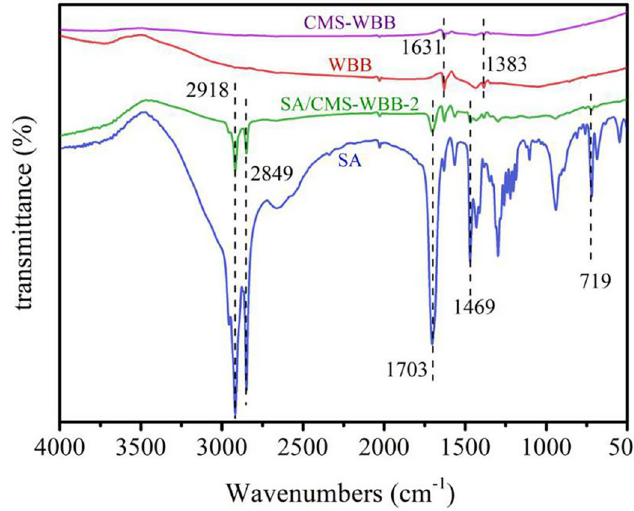
Figure 6. FTIR spectra of WBB, CMS-WBB, SA/CMS-WBB-2, and SA.